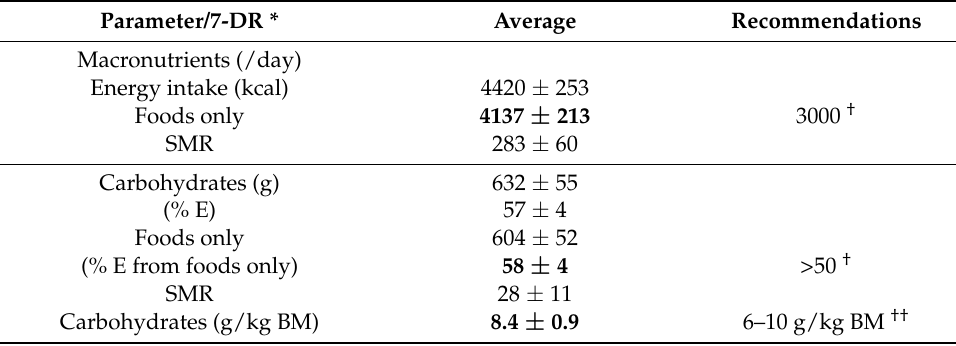
Table 2. Energy and macronutrient intake compared with